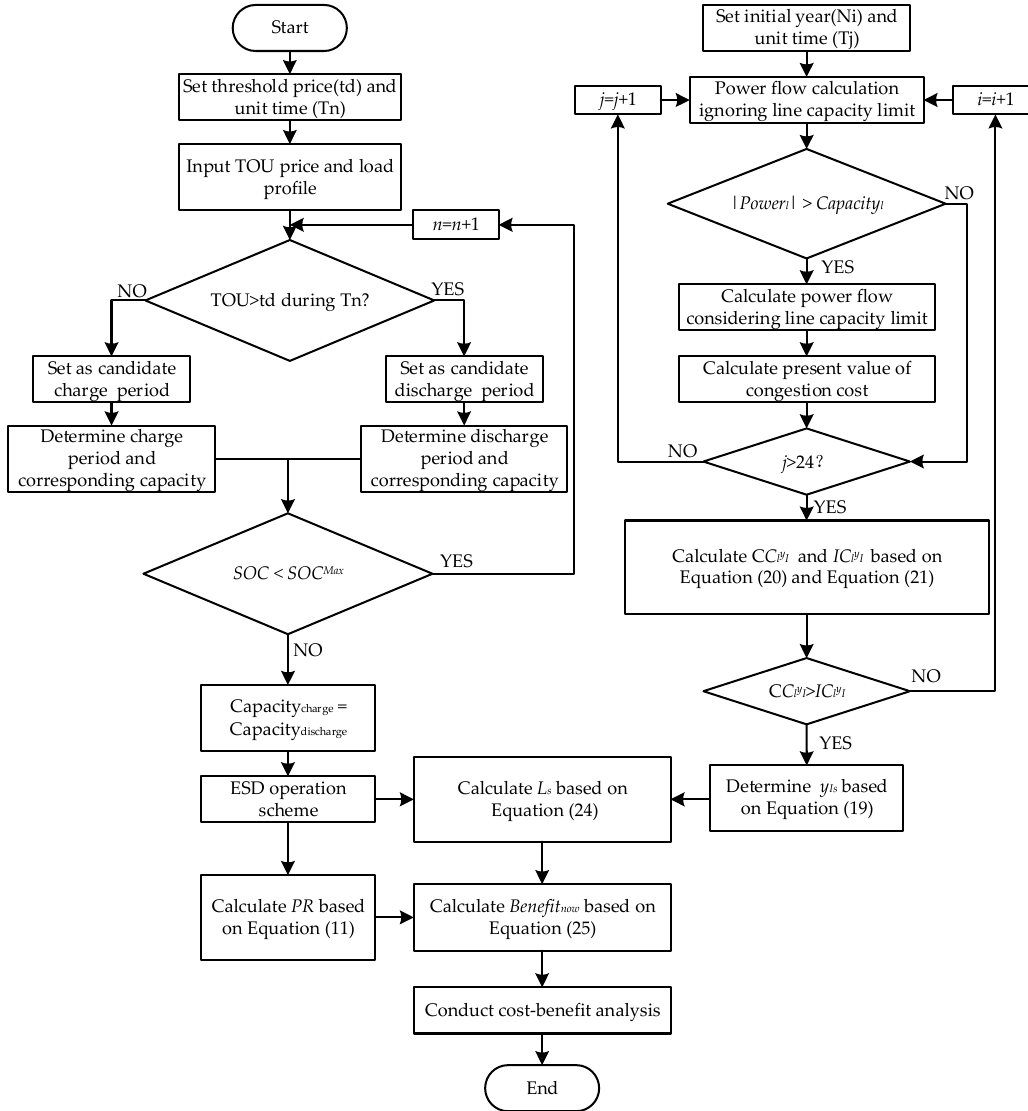
Figure 1. General procedure for cost–benefit analysis.